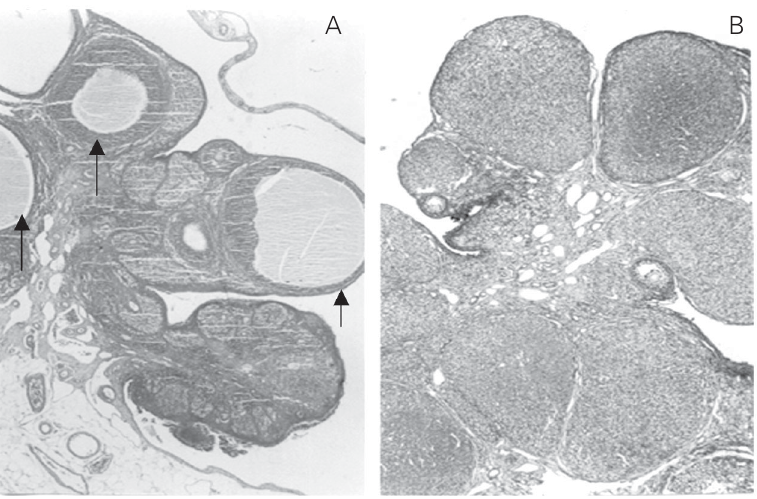
Figure 2. Morphological aspects of the ovaries of the rats from group I (pinealectomized ovariectomized melatonin-treated group), before (A) and after (B) melatonin administration. The induction and regression of ovarian polycystosis (arrows) is indicated by a significant reduction of the ovarian cysts after melatonin treatment. Hematoxylin and eosin (±